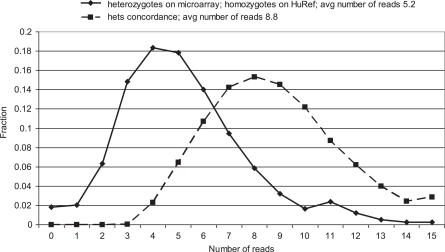
Distribution of HuRef Read-Depth Coverage for Genotyped SNPsDistribution plot of number of underlying reads (average number of reads = 8.8) in HuRef heterozygous SNPs confirmed by the Affymetrix and Illumina genotyping platforms. This is compared to a distribution (average number of reads = 5.2) for SNP detected by the platforms but missed in the HuRef assembly.